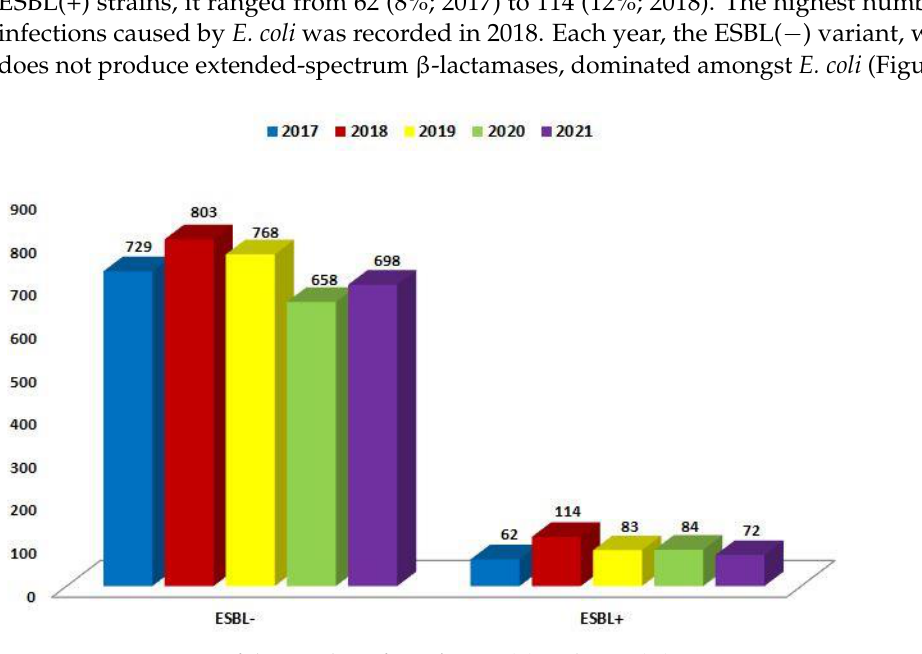
Figure 1. Comparison of the number of E. coli ESBL(+) and ESBL( − ) strains in 2017–2021. Each year, the percentage of ESBL( − ) strains was almost 10 times higher than ESBL(+) strains and ranged from 88% to 92% over the past five years (Figure 2, Table 3). It was significantly higher than the frequency of E. coli ESBL(+) infections (Table 3). The percent- age of ESBL(+) strains, on the other hand, ranged from 8% to 12% and did not increase significantly for E. coli . However, it significantly differs in particular years ( p < 0.05)—there is a higher observed frequency of ESBL( − ) strains in 2017 and ESBL(+) strains in 2018 than expected. Table 3. Number of E. coli ESBL(+) and ESBL(−) strains in 2017–2021.